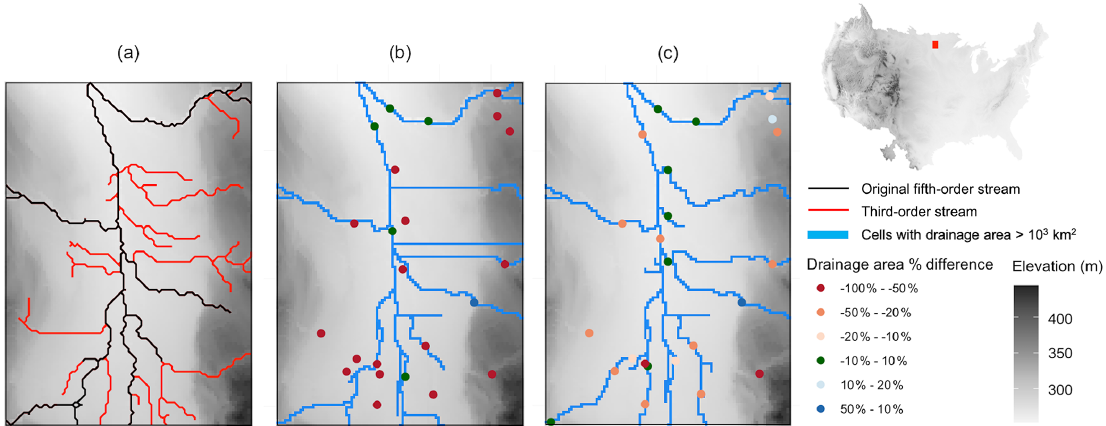
Figure 6. Panels (a) , (b) and (c) are maps illustrating the impact of stream order used for the drainage mask on the resulting drainage network for a selected valley in the northern portion of CONUS (highlighted in the red box in the upper-right CONUS map). The background map is the elevation. (a) The third (red) and fifth (black) order stream network. Panels (b) and (c) are results from fifth-order stream network and third-order stream network respectively. Blue cells in panels (b) and (c) are cells with drainage area over 1000km 2 after processing. Colored dots in panels (b) and (c) represent the percentage difference of drainage area between topographic processed and USGS.